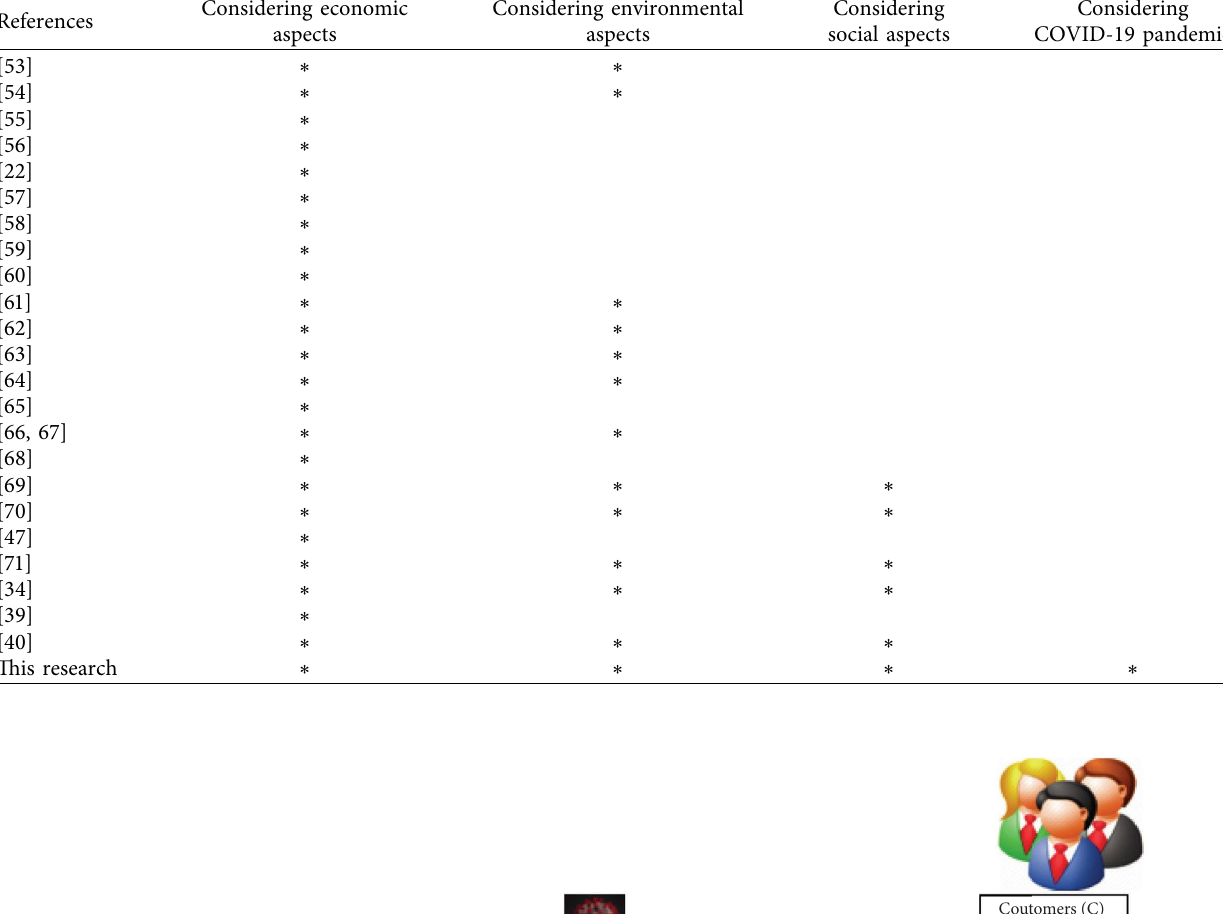
Table 1: Different aspects of the SRN consider the COVID-19 pandemic.